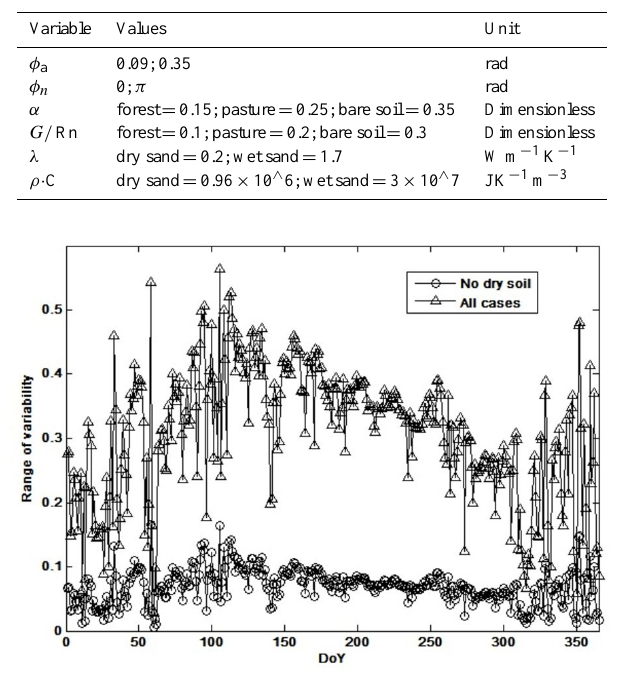
Fig. 9. Daily values of the range of variability of the ratio r for all cases (open triangles) calculated using equation 8 and the parameter values in Table 8, respectively, leaving out the 12 cases calculated with the dry soil thermal admittance (open circles).